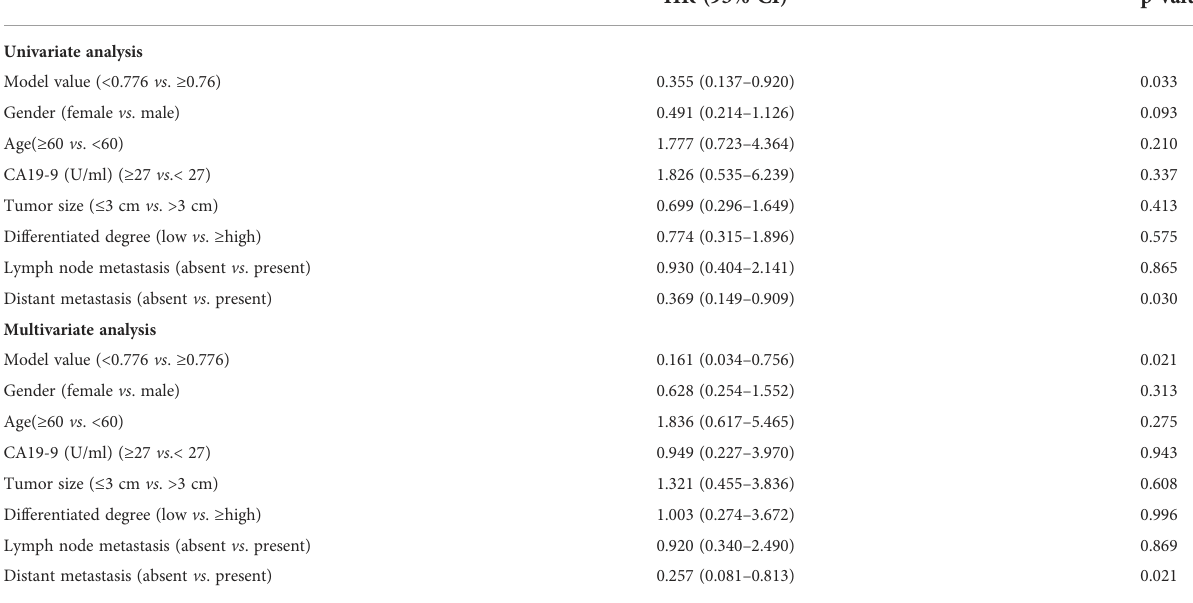
TABLE 2 Univariate and multivariate analysis for overall survival of PC